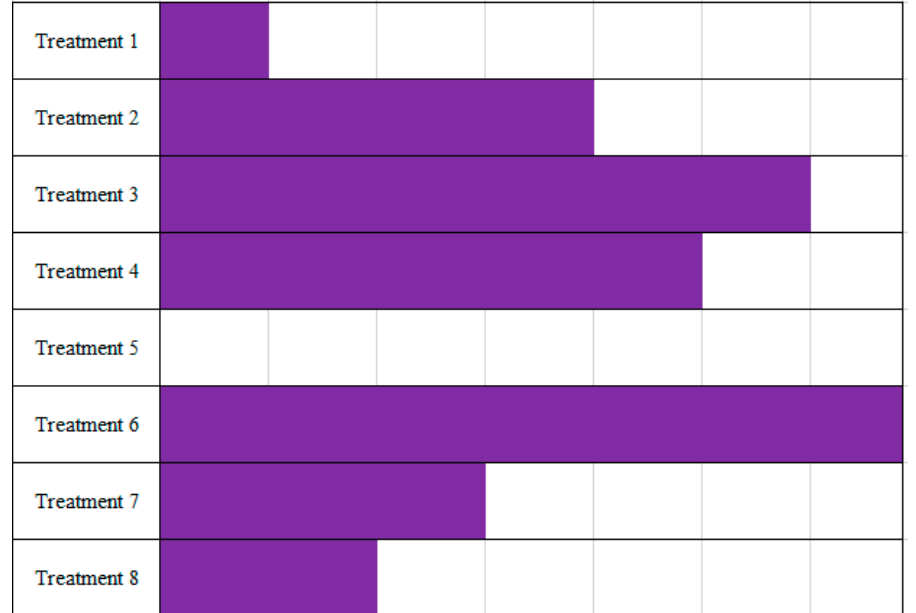
Figure A9. The layout of UV irradiation for all eight treatments (top view). Each treatment represents a quartz tube, which is equally “divided” into seven sections. The purple-colored grid indicates UV irradiation areas, while white-colored spaces are shielded from UV. The pictures of this experimental setup with sections of PVC tubes shielding the quartz tubes are provided in Supplementary Materials. The arrangement of the shielding layout was randomly selected and remained the same for the experiments.